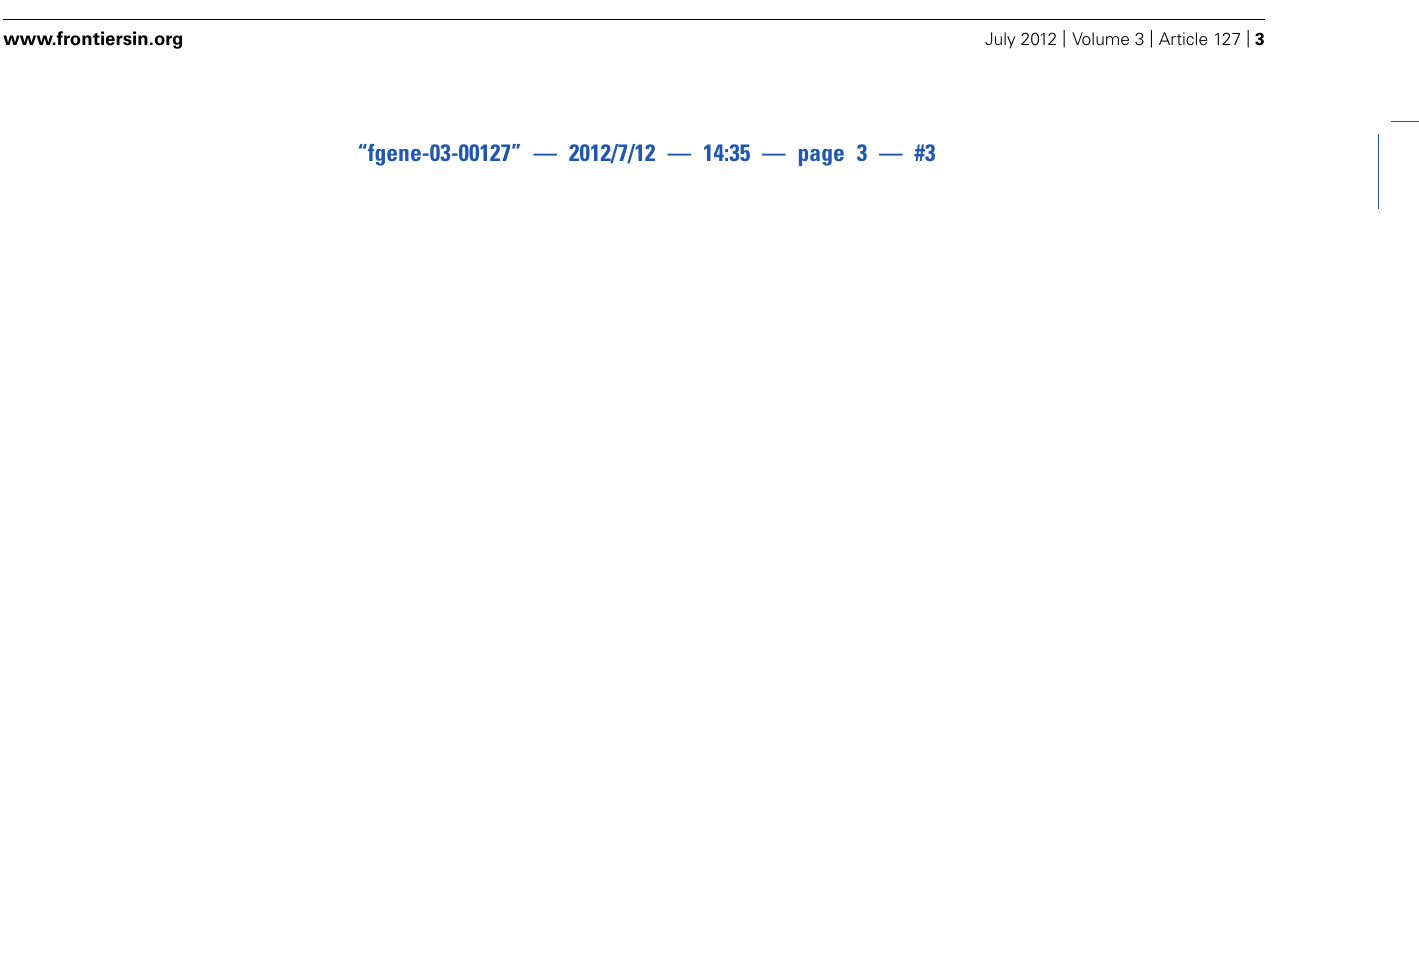
to be required for asymmetric assembly of mammalian Ago1–4-RISC or fly Ago1 RISC. In contrast, in flies the Dicer-2/R2D2 heterodimer senses the asymmetry of siRNA duplexes and such binding is a prerequisite for Ago2-RISC assembly. (B) In mammals, central mismatches are preferred for RISC loading, whereas mismatches in the seed and 3 (cid:2) -mid regions promote slicer-independent unwinding. Such mismatches are highlighted in yellow. Duplex loading requires ATP and the Hsc70/Hsp90 chaperone machinery, while both slicer-dependent unwinding and slicer-independent unwinding do